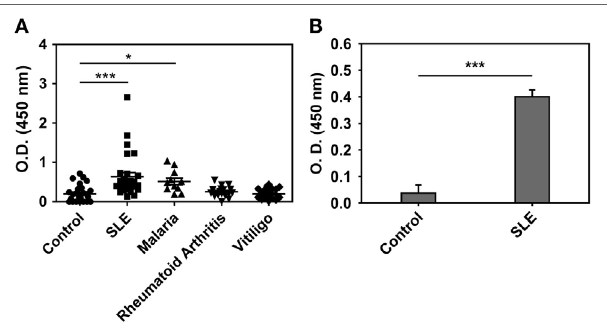
FigUre 1 | Anti-human Hb (hHb) antibodies in human sera. (a) Reactivity of IgG and IgM antibodies in the sera of healthy volunteers (control, n = 28), SLE patients ( n = 28), malaria ( P. falciparum ) patients ( n = 10), rheumatoid arthritis patients ( n = 20), and vitiligo patients ( n = 20) to hHb. Data represent mean ± SEM. (B) Reactivity of IgG immunoglobulins, purified from SLE sera containing antibodies reactive toward hHb ( n = 8) and from control sera ( n = 8), to hHb. Data represent mean ± SEM (* p < 0.05, *** p < 0.001).